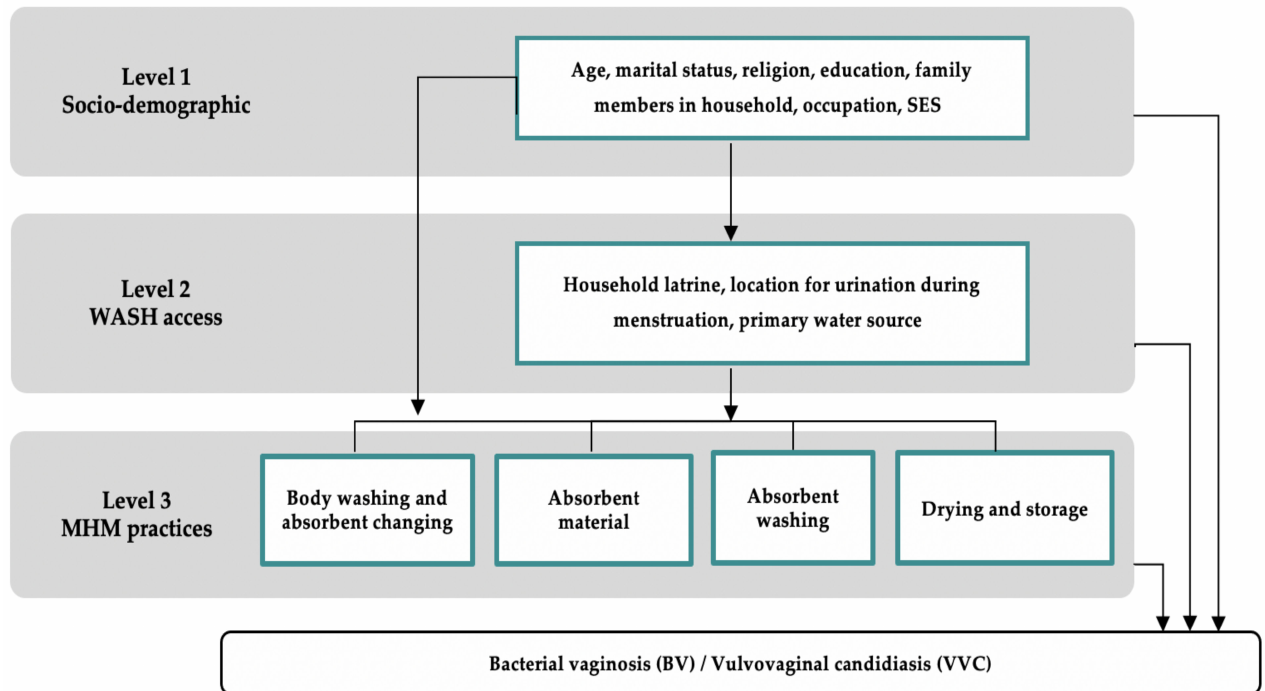
Figure 1. Hierarchal conceptual